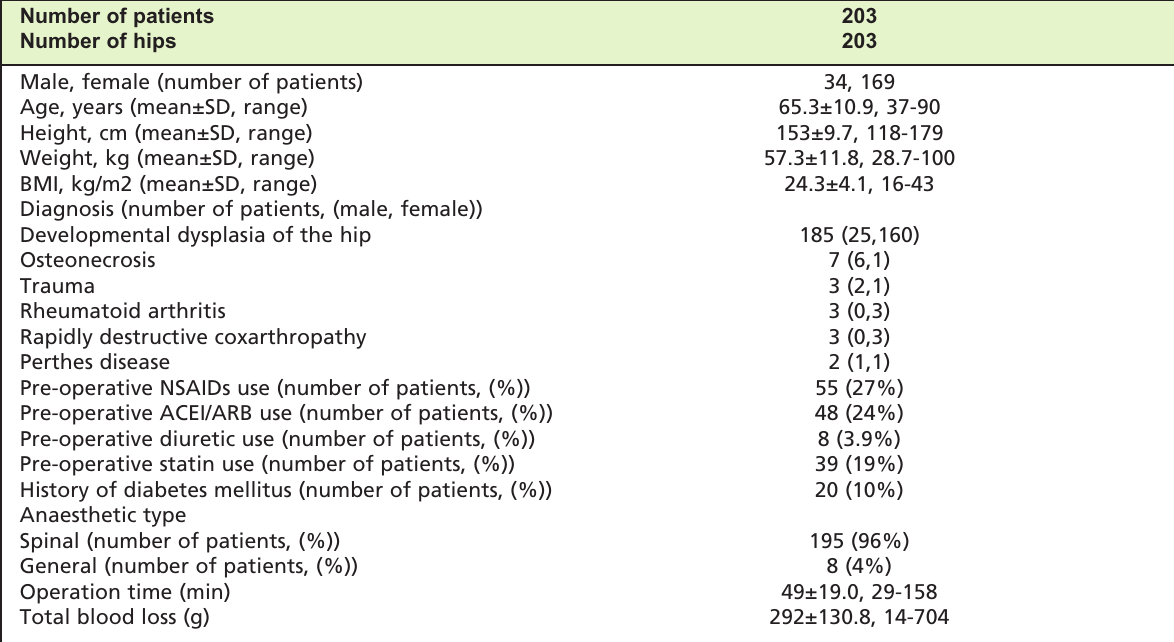
Demographic Characteristics of the Study Table I: